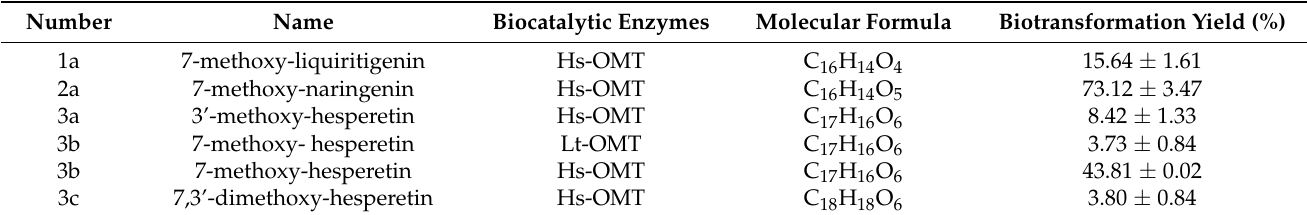
Figure 1. Biotransformation of flavonoid substrates by HsOMT and LtOMT. * represents equivalent endogenous substrate. Table 1. Biotransformation products and yields of flavonoid substrates by Hs-OMT and Lt-OMT.